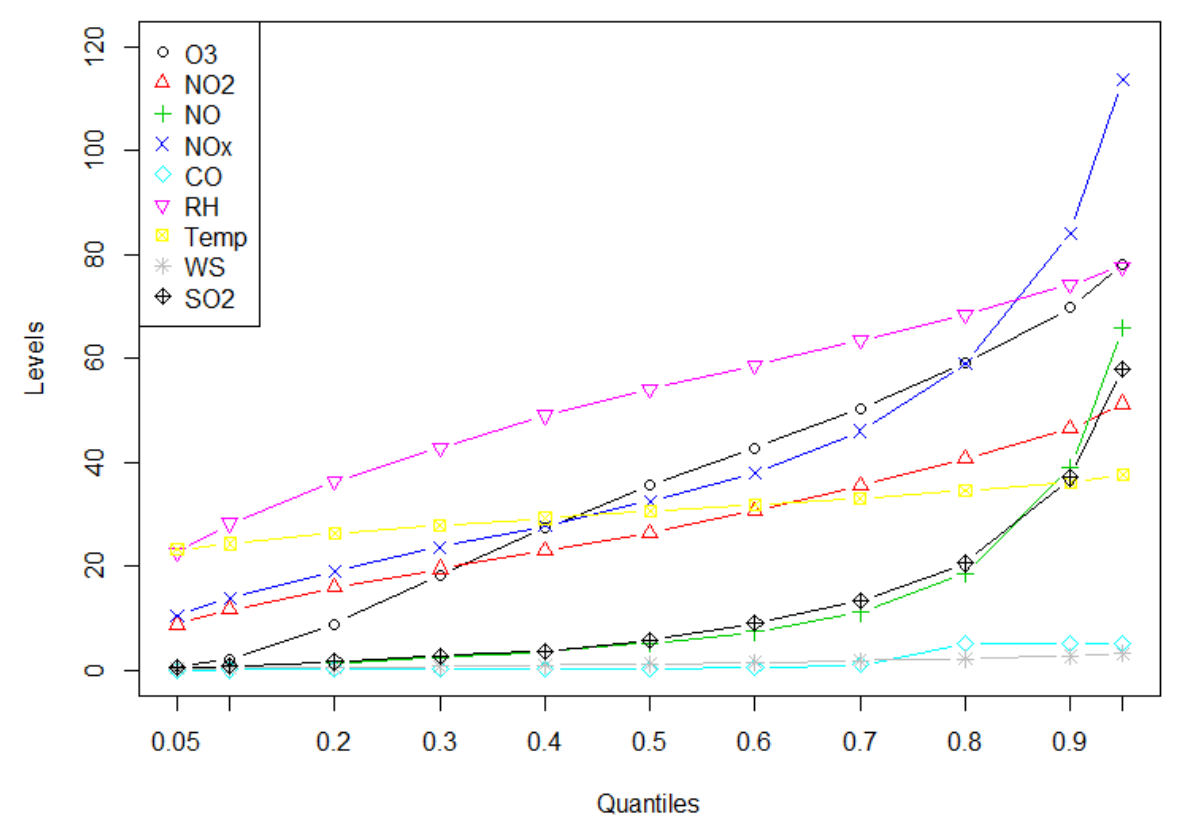
Figure 3. Levels of various air pollutants and meteorological parameters at different quantiles of distributions. All of the pollutants are measured in ppb, except for CO, which was measured in ppm. In the figure, WS stands for wind speed (m/s), WD for wind direction (degree from the north), Temp for temperature (°C), and RH for relative humidity (%).